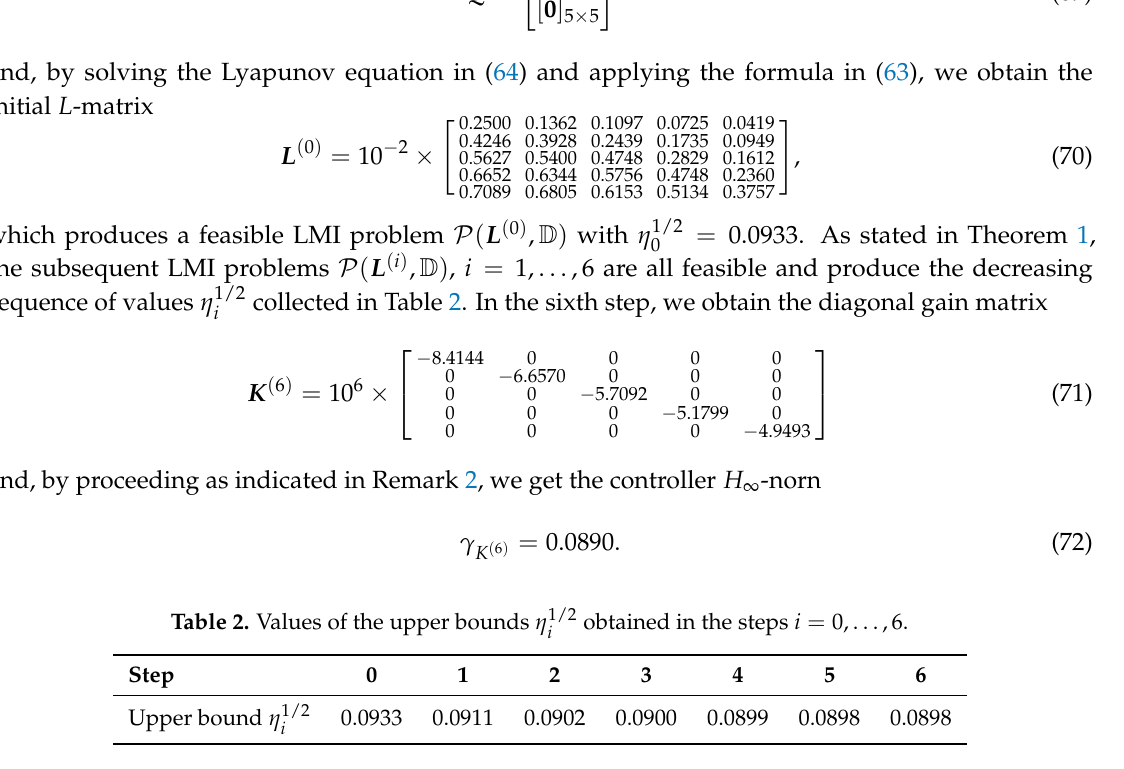
Table 2. Values of the upper bounds η 1/2